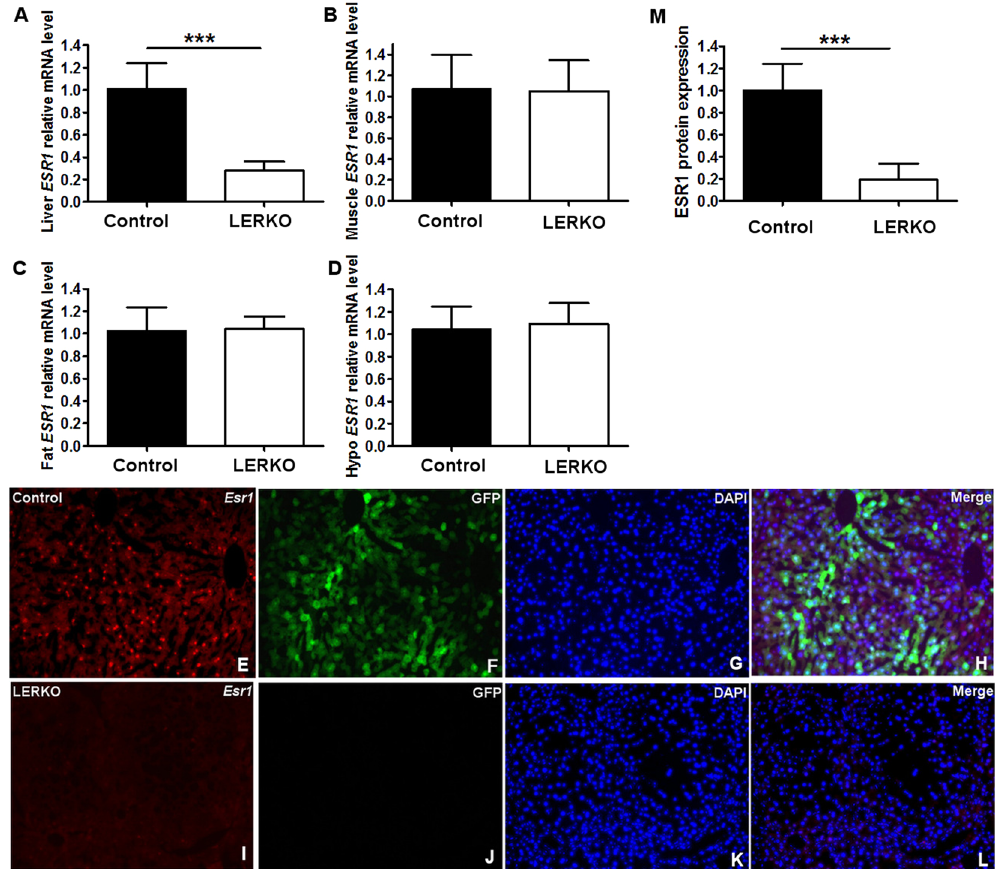
Figure 1. Knock down of hepatic ESR1 in the LERKO mice. ( A – D ) mRNA levels of ESR1 in liver, muscle, fat and hypothalamus measured by q-RT-PCR. ( E–L ) immunofluorescence staining of hepatic ESR1 from Control ( E – H ) and LERKO mice liver ( I – L ). ( E , I ) ESR1 staining. ( F , J ) GFP fluorescence. ( G , K ) DAPI staining. ( H , L ) merged images. ( M ) ImageJ quantification of immunofluorescence staining (n = 6). Data are expressed as the means ± SD, * p < 0.05 versus Control, ** p < 0.01 versus Control, *** p < 0.001 versus